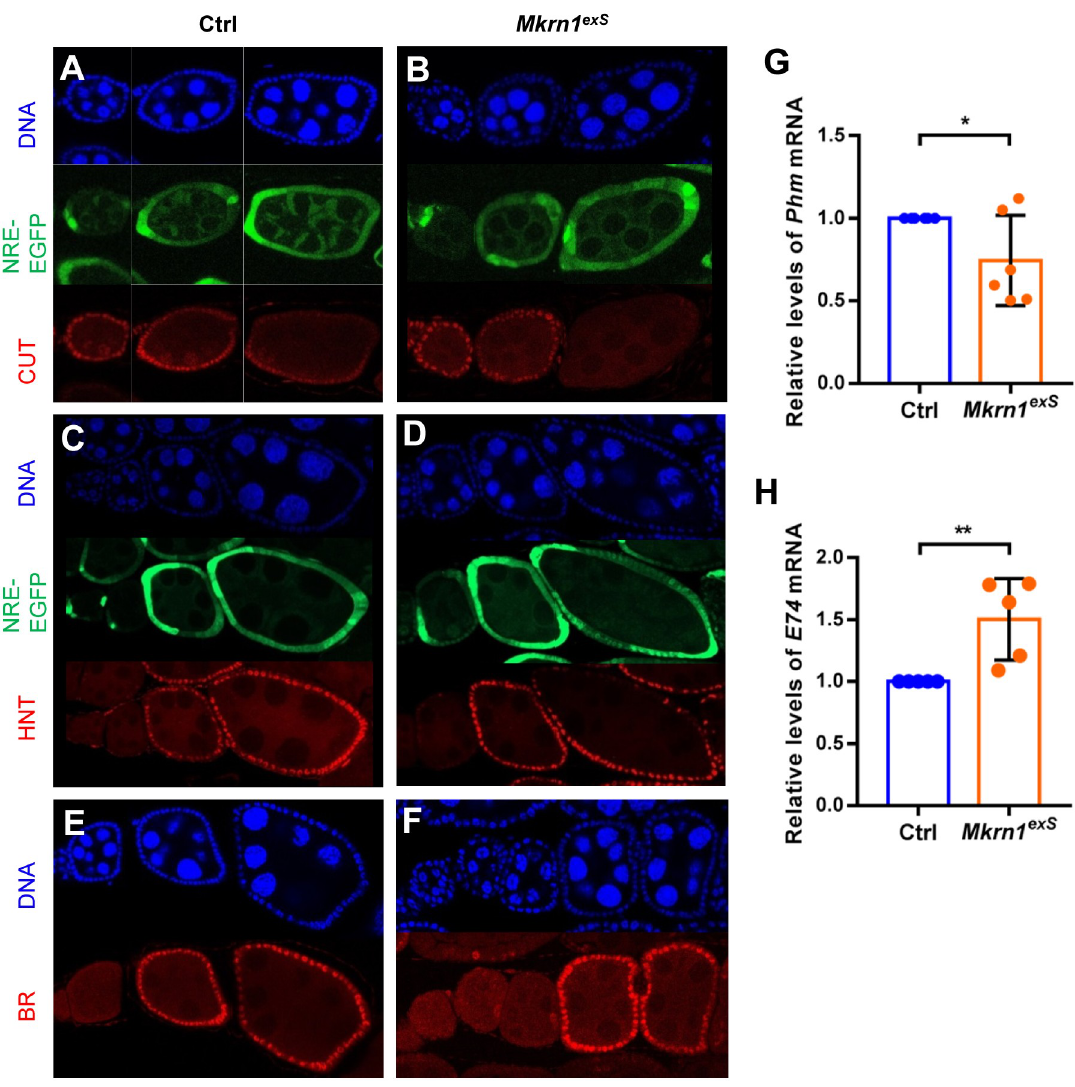
Fig 3. Expression of Notch targets and ecdysone-responsive genes were not affected in Mkrn1 -null Drosophila ovaries. (A–F) Egg chambers from control and Mkrn1 exS flies were stained for Cut (A and B), Hnt (C and D), and Br (E and F) (shown in red). (A–D) NRE-EGFP (GFP) was used as a Notch signaling reporter and was activated around stage 6 in both the control and Mkrn1 exS ovaries. Cut was expressed up to stage 6 and Hnt was activated around stage 6 in both control and Mkrn1 exS ovaries. Br was also activated after stage 6 in both the control and Mkrn1 exS ovaries. (G and H) Control and Mkrn1 exS ovaries were dissected from one-day-old females. Quantitative real-time PCR was performed to measure mRNA levels of Phm (G) and E74 (H). Relative mRNA levels are shown and error bars represent SEM from five independent experiments. Asterisks indicate statistically significant differences (Student’s t-test: � P < 0.05; �� P < 0.01).